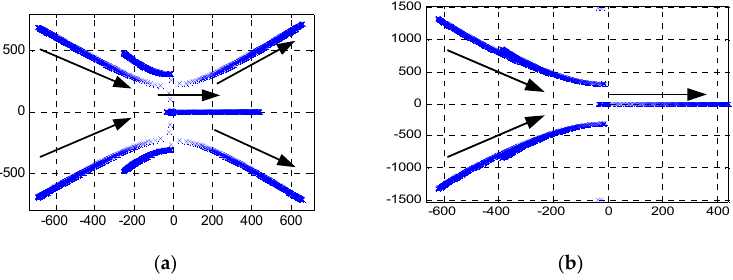
Figure 6. ( a ) The system root locus varies along with active power drooping coefficient m p variation under fundamental frequency; ( b ) The system root locus varies along with reactive power drooping coefficient n q variation under fundamental frequency.